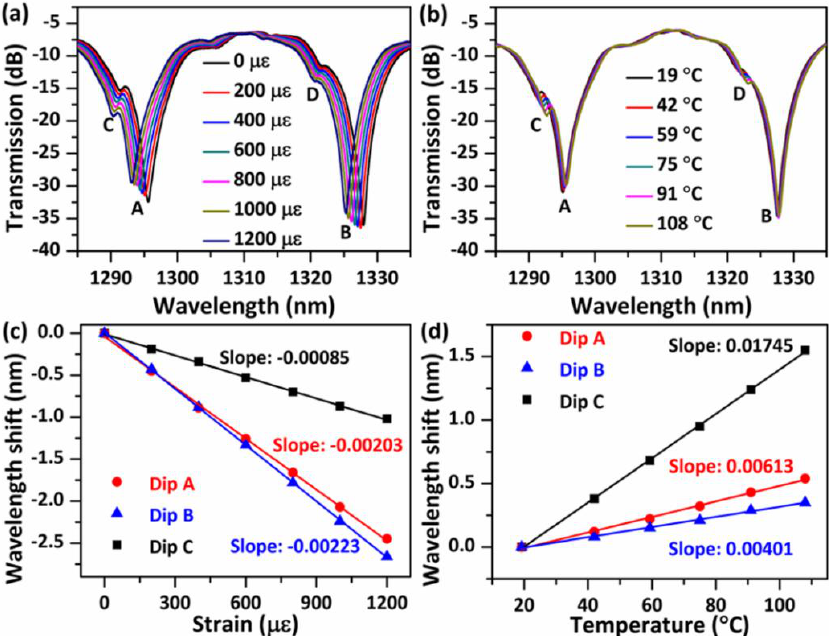
Figure 4. Measured spectral responses of S-48 versus ( a ) strain in the range from 0 to 1200 με and ( b ) temperature in the range from 19 °C to 108 °C, and the corresponding wavelength shifts of dips A, B, and C in relation to ( c ) strain and ( d ) temperature. The straight lines are linear fits for the measured data.